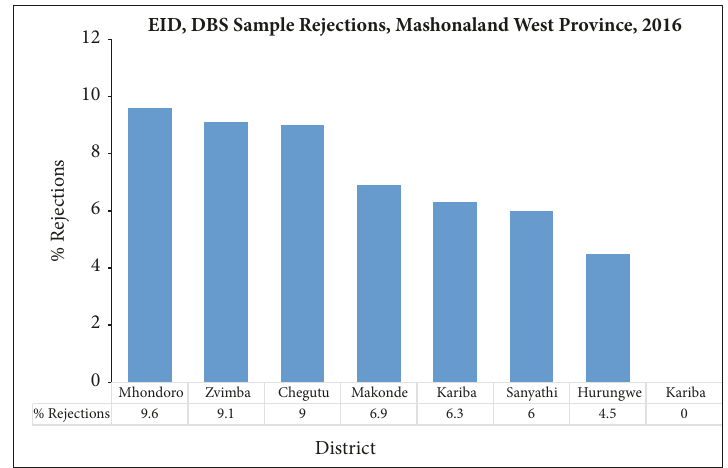
Figure 1: DBS rejections per district, Mashonaland West Province, Zimbabwe,